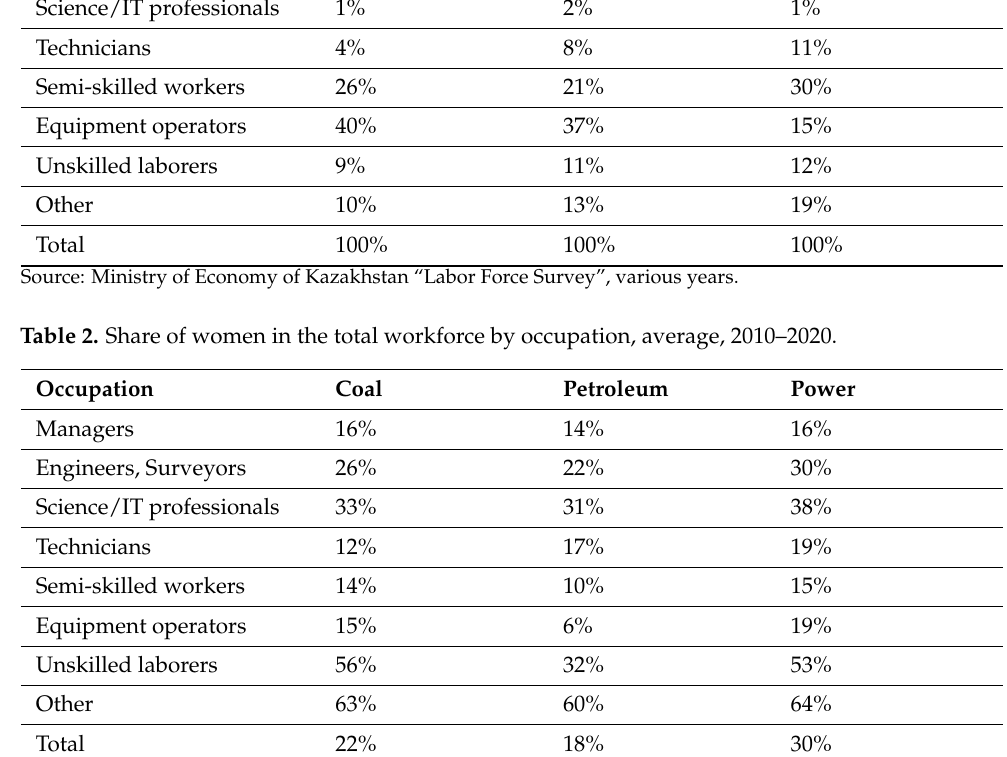
Unskilled laborers